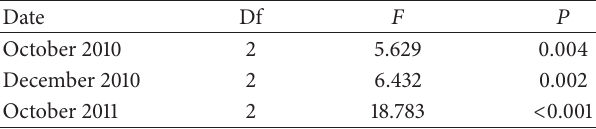
Table 2: Effects of treatments on height